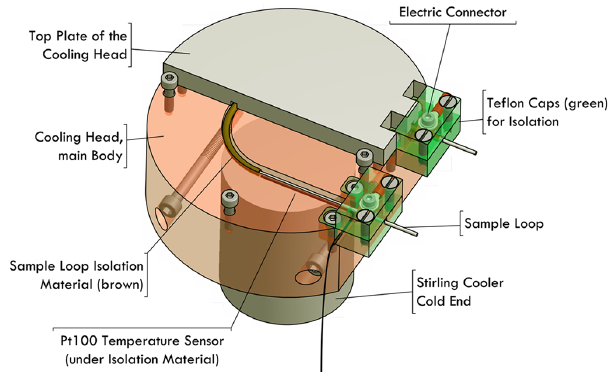
Figure 1. Schematic of the cooling head. The aluminium cylin- der which contains the sample loop is placed on top of the Stirling cooler’s cold end. Electric connectors are located at each end of the sample loop for resistive